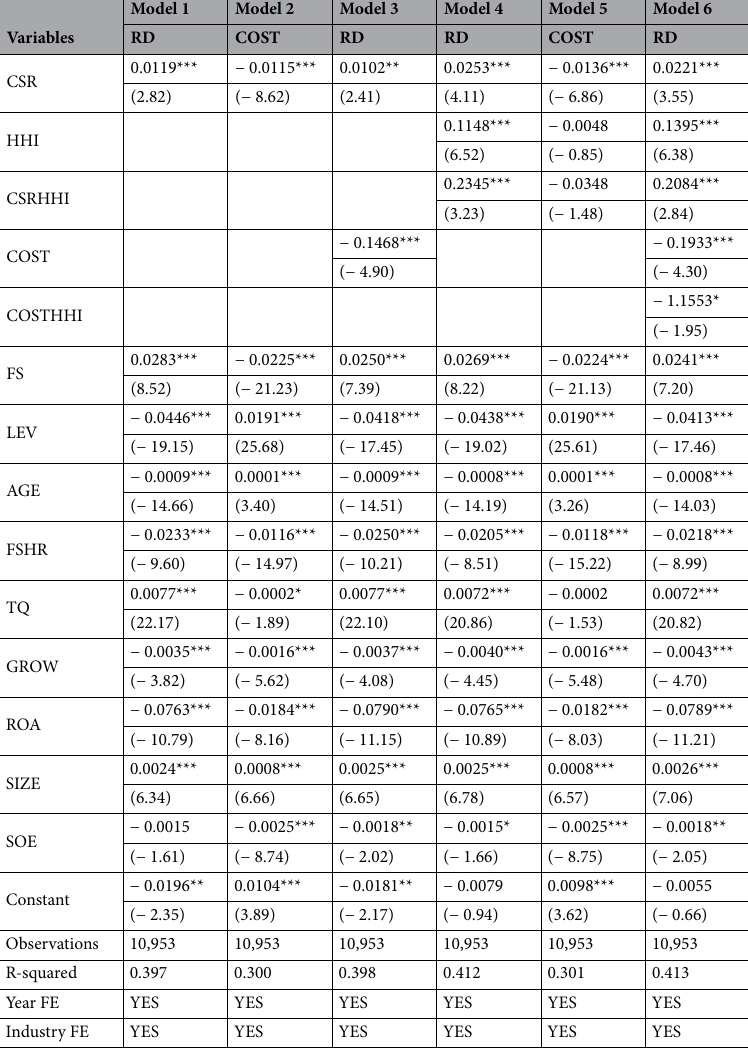
Table 6. Robustness test—substitution variables. ***, ** and * respectively indicate that the parameter estimation is significant at the levels of 0.01, 0.05 and 0.1. The “t” value is in parentheses.